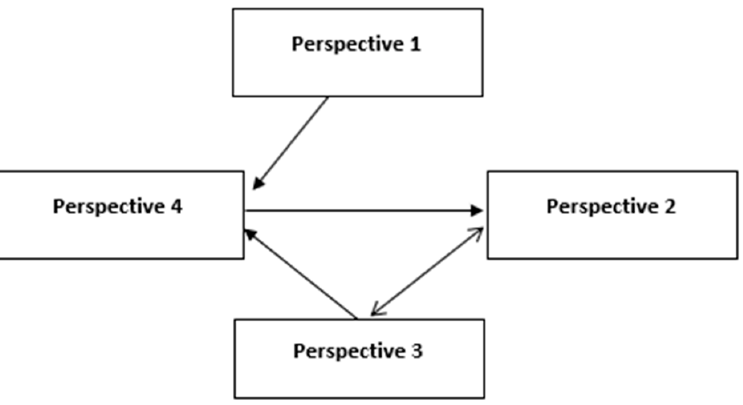
Figure 2. Impact-relation map for the perspectives.